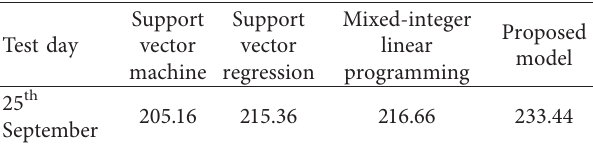
Table 5: Comparing various methods with the proposed test case for obtained